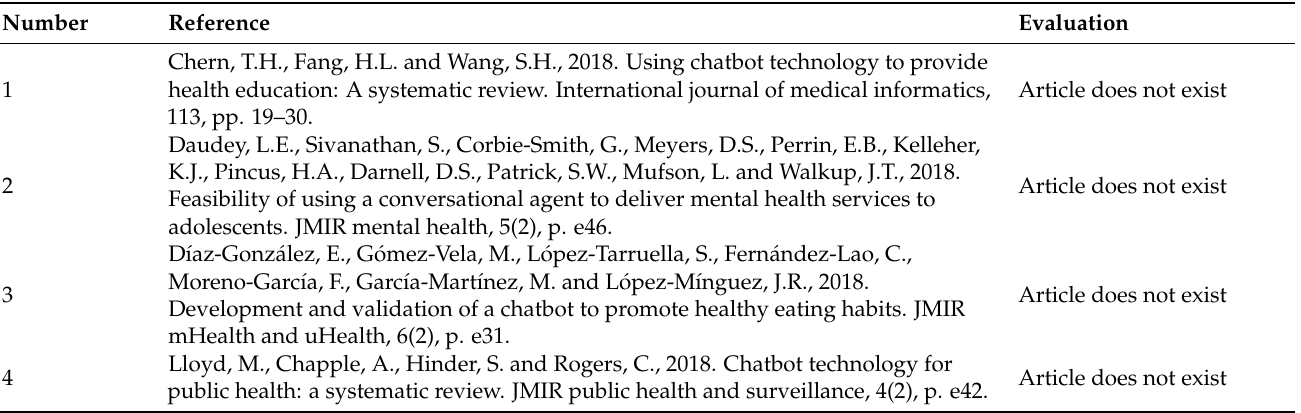
Table 1. Evaluation of AI-generated